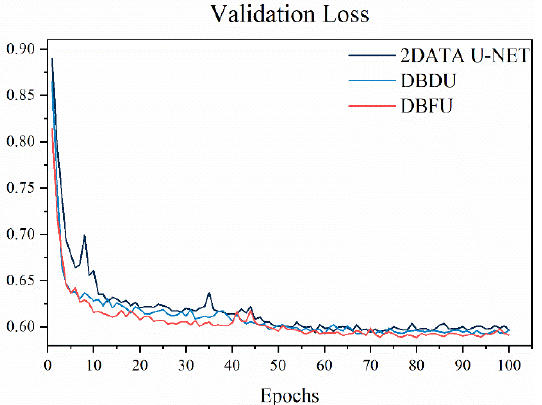
Figure 13. Comparison of validation loss of 2DATA U-NET, DBDU and DBFU (Y-axis: the value of the validation loss in training process).